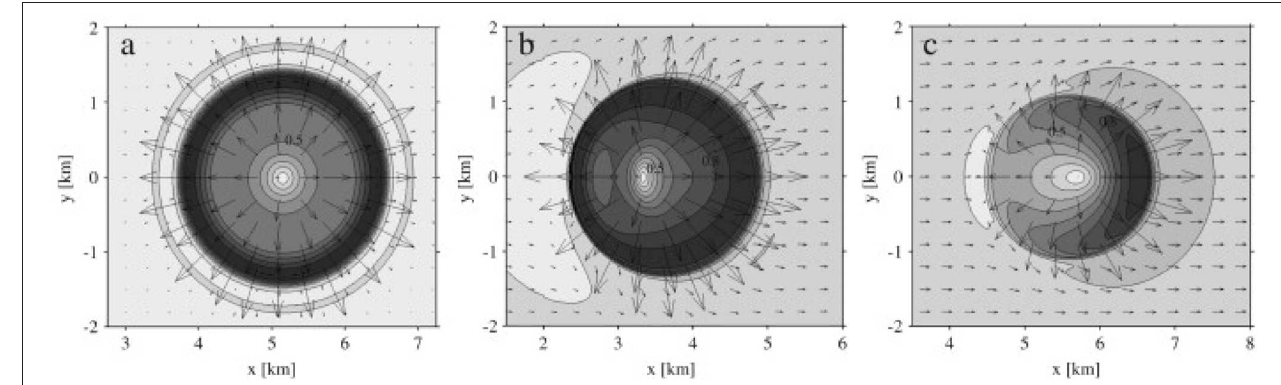
FIGURE 6 | Horizontal z = 10 m velocity contour and vector plots at the time of the storm maximum velocity: (A) stationary downdraft. (B, C) non-stationary simulations. Reproduced from Mason et al. (2010) with permission from Elsevier. et al. (2006), using a k- ε model, by Kim and Hangan